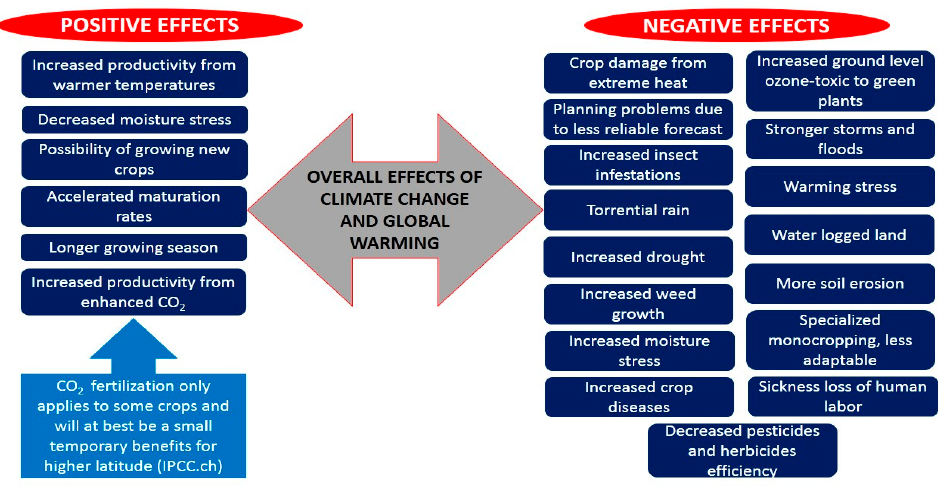
Figure 4. Overall positive and negative effects of climate change and global warming on crops and humans.